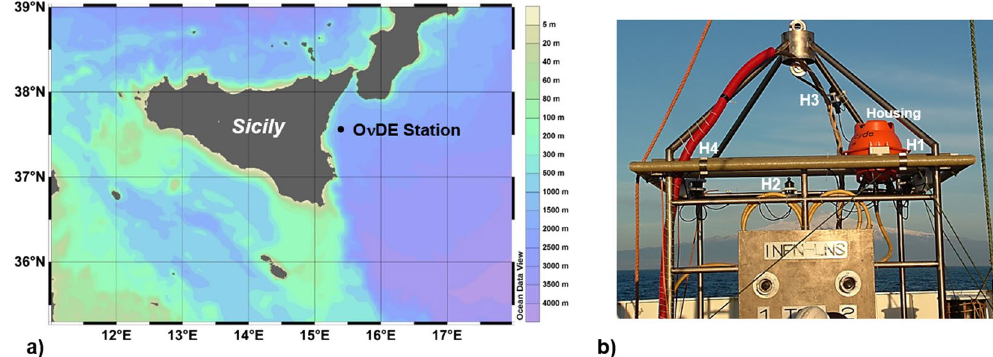
Figure 1. The O ν DE station. ( a ) Site of installation of the O ν DE acoustic array (NEMO Test Site, 2,100